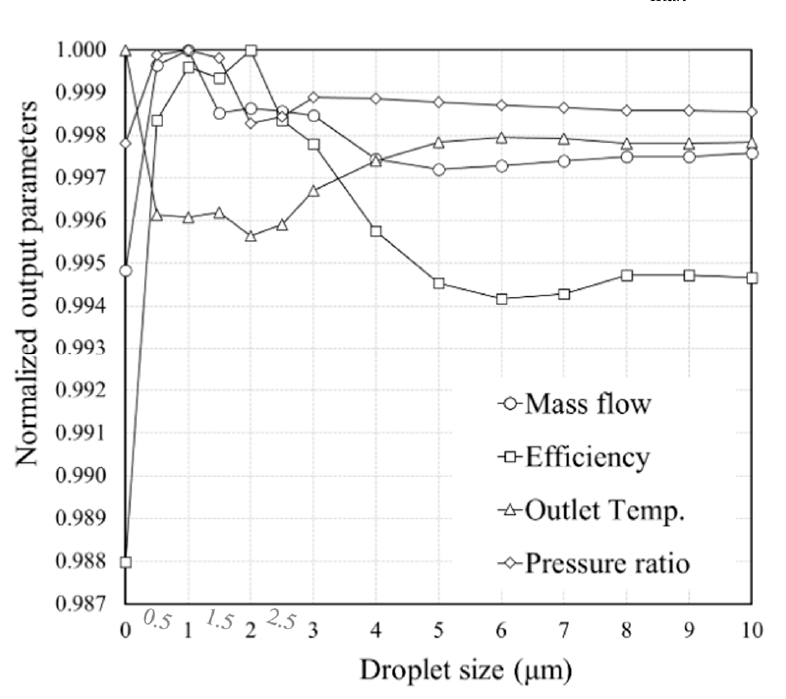
Figure 9. Effect of the different droplet sizes on the centrifugal compressor performance (injecting mass flow rate of 0.2%) at the design point.